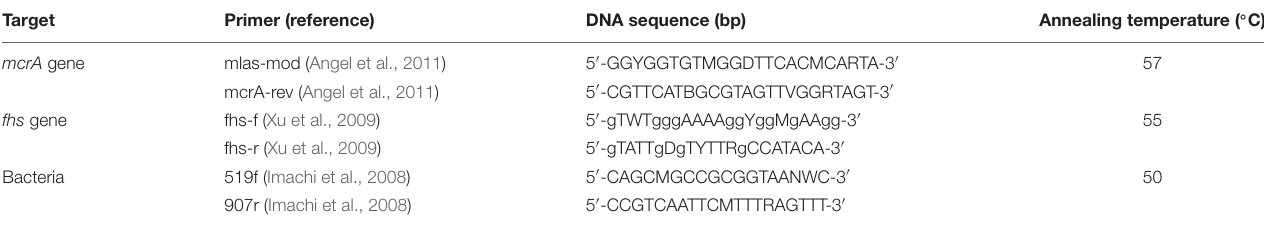
TABLE 1 | Oligonucleotide sequences used for quantitative PCR (qPCR)